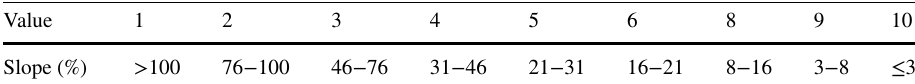
Table 2 The slope variable and